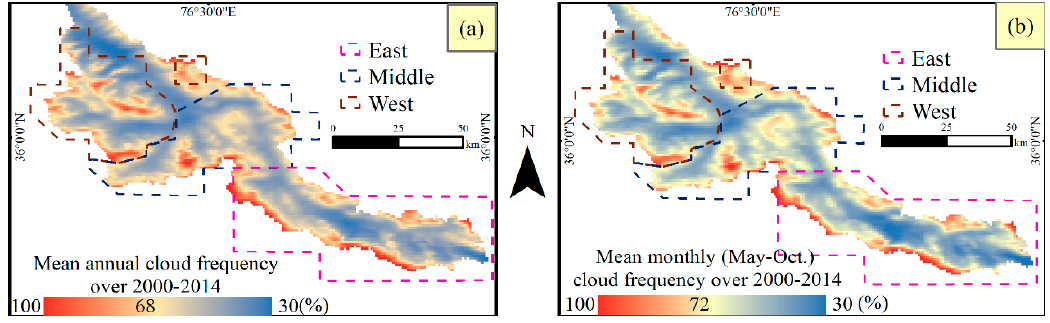
Figure 17. Mean annual ( a ) and mean monthly ( b ) cloud cover fraction of Shaksgam Valley derived from Global 1-km Cloud Cover observation database [35].